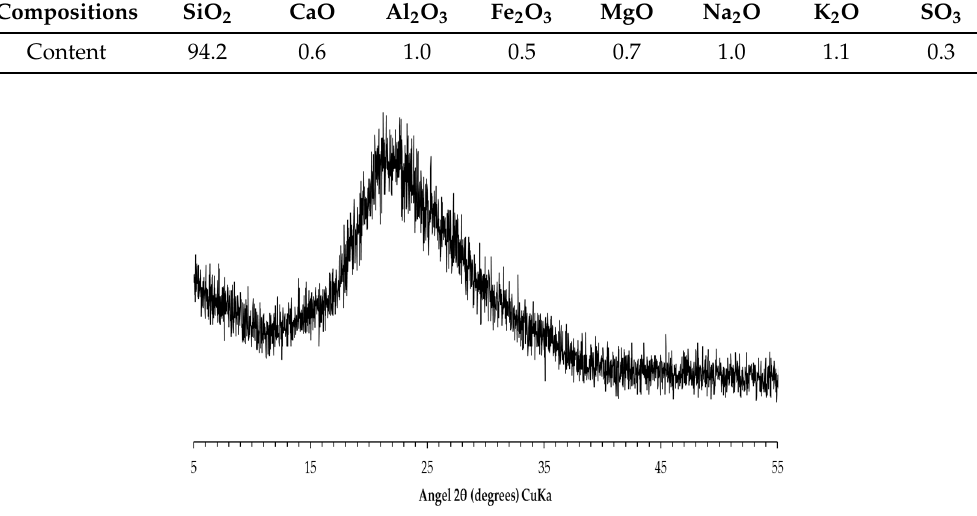
Table 1. Chemical composition of the used silica fume/wt %.